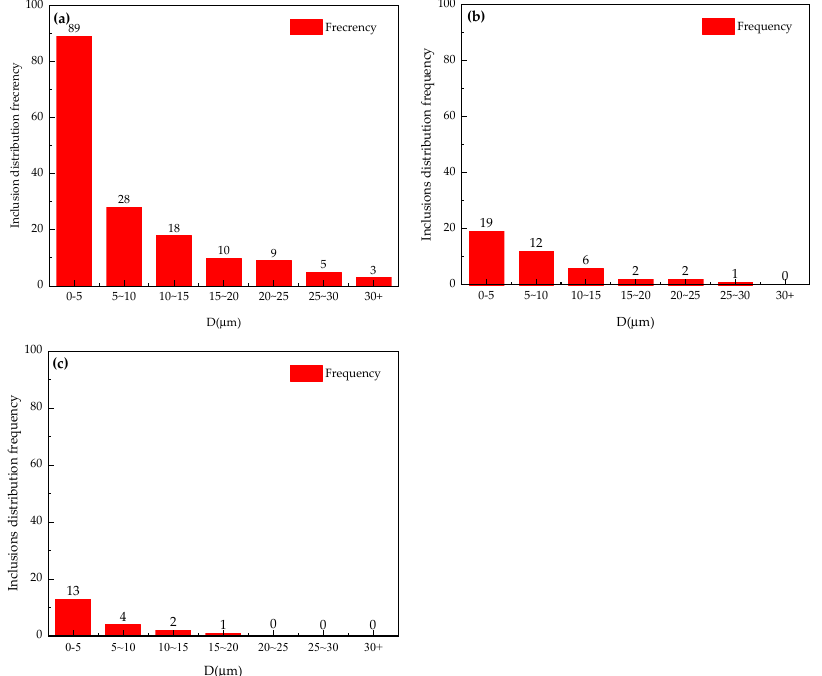
Figure 5. The total inclusion content in three purification processes.